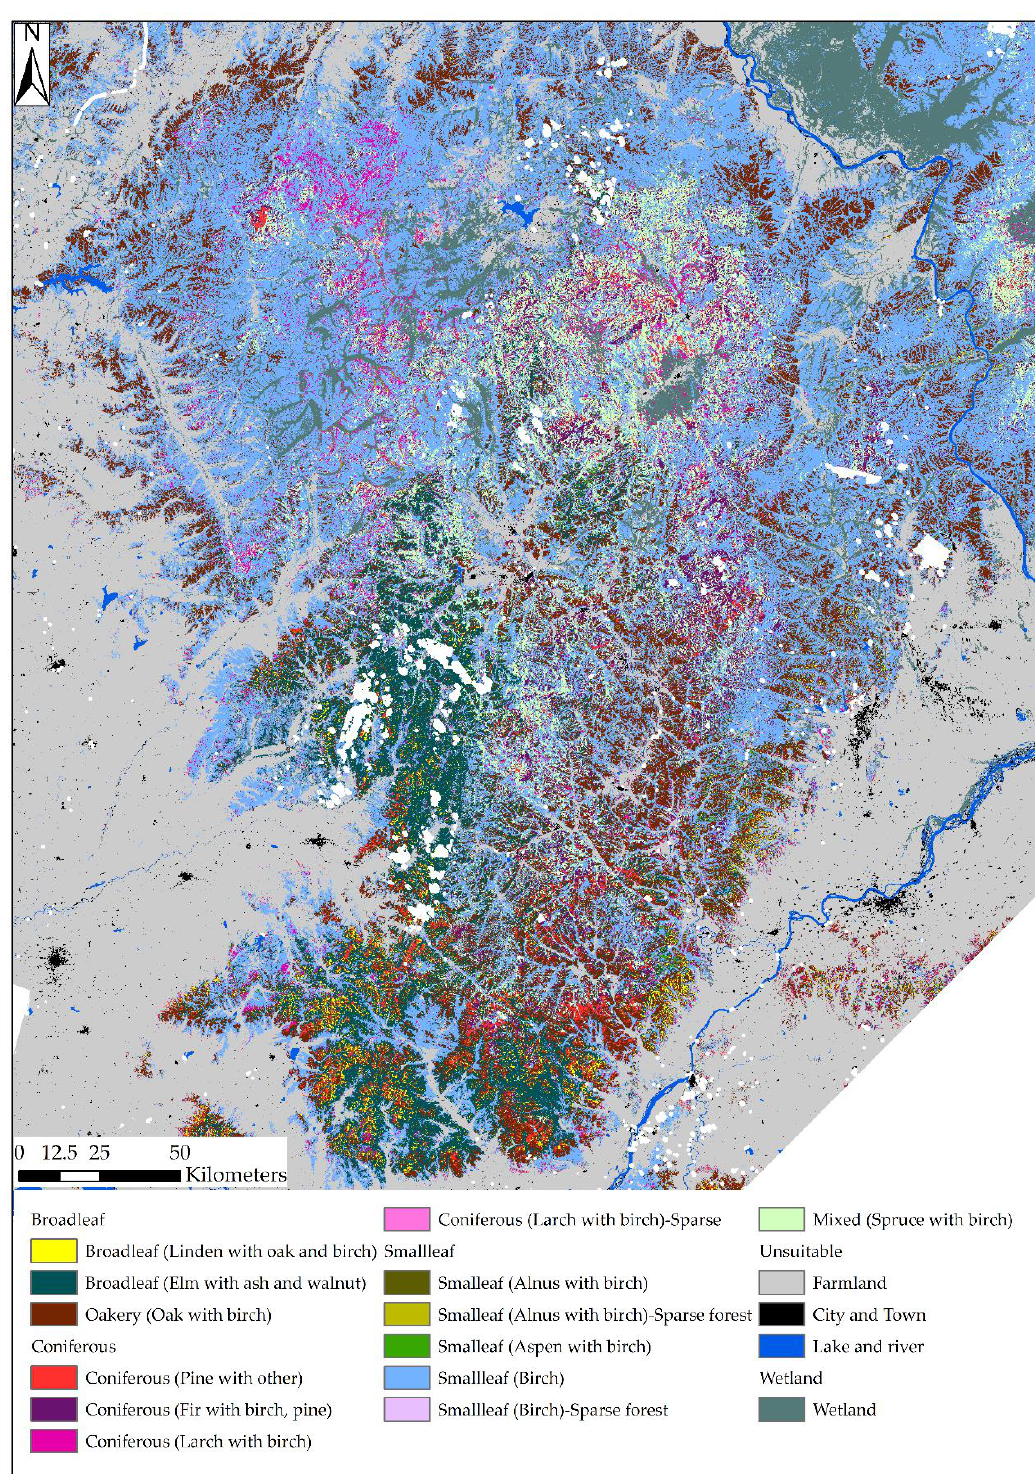
Figure 2. Map of habitat types of the Lesser Khingan obtained by supervised classification of environmental variables. Scale 1:1,500,000. White color corresponds to clouds and shadows in a multispectral image.